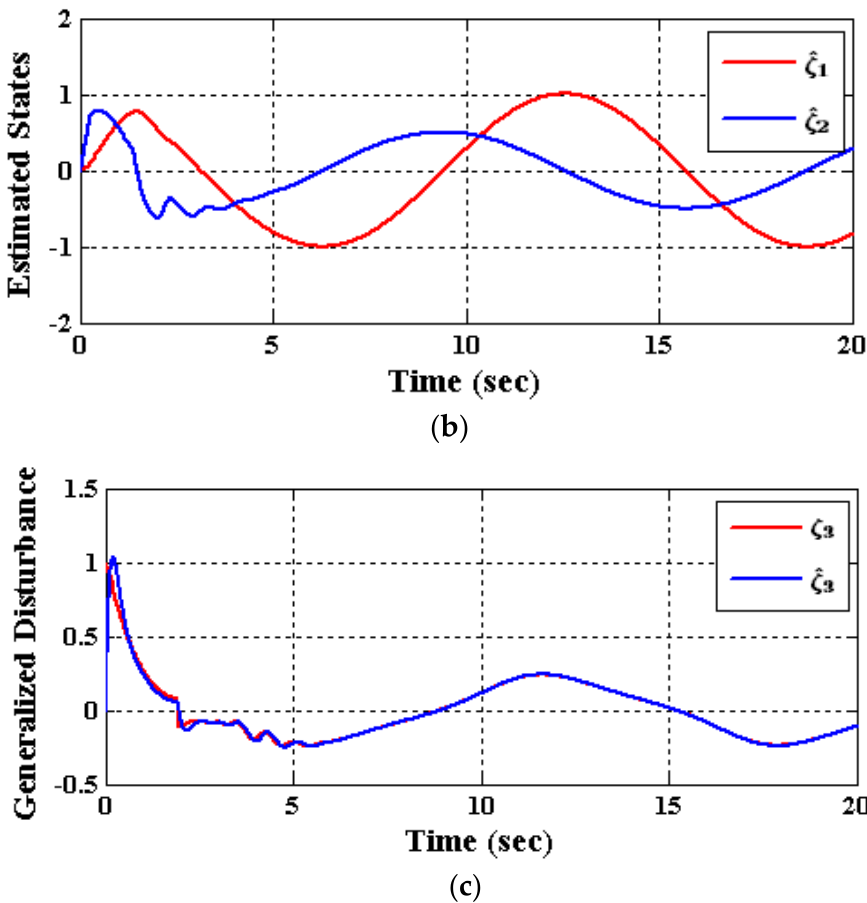
Figure 6. The states of the model (25) using NHOESO; ( a ) actual states ( ξ 1 , ξ 2 ) T ; ( b ) estimated states (cid:1) T (cid:0) ˆ ξ 1 , ˆ ξ 2 ; ( c ) generalized disturbance (cid:3435)𝜉 (cid:2871) , 𝜉(cid:4632) (cid:2871) (cid:3439)